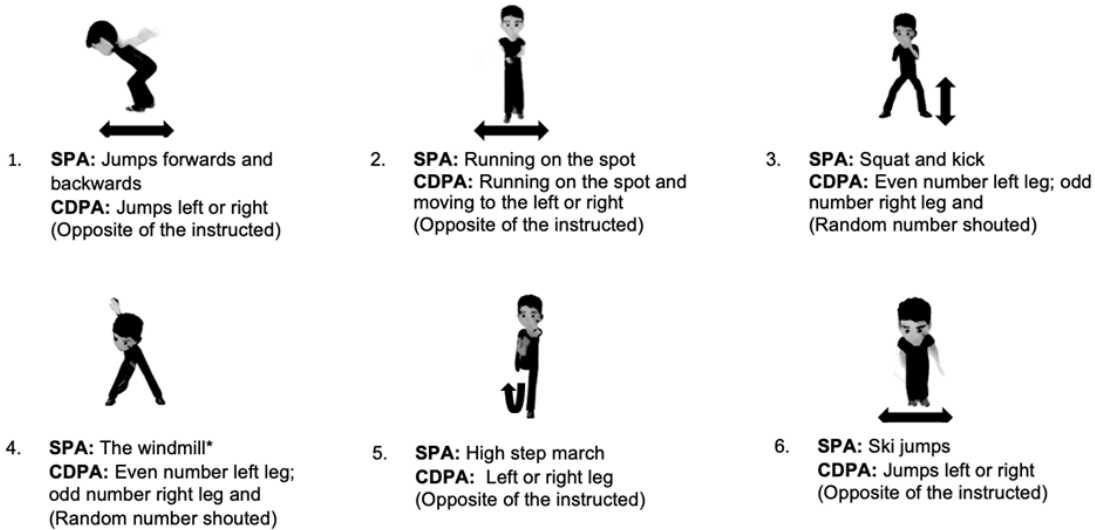
Figure 2. Visual representation of the SPA exercises/movements presented to the participants.